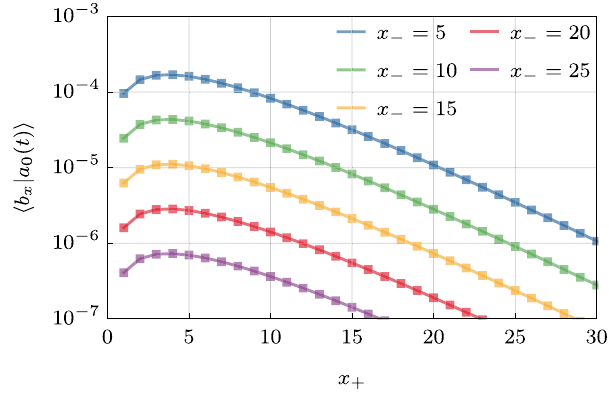
FIG. 3. Exact correlations computed numerically (solid lines) and the prediction of Eq. (38) (squares) for x ∈ Z for a quantum circuit with elementary gate given by gate 2 of Table I and maximal density of defects δ ¼ 1 .